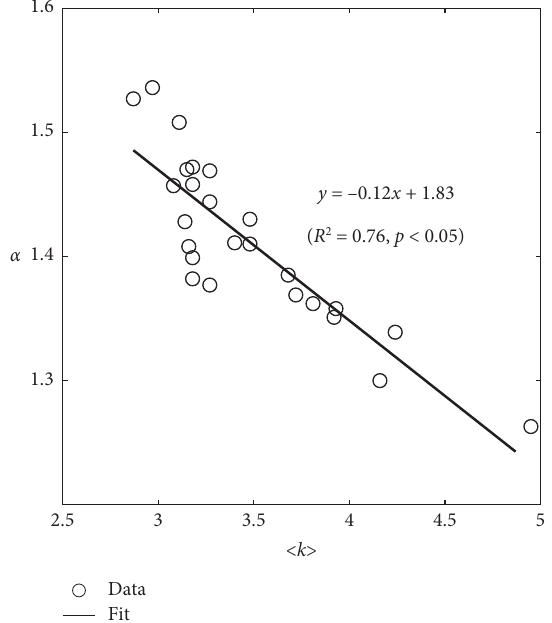
Figure 5: Exponents of cumulative degree distributions versus < k > of 25 urban road